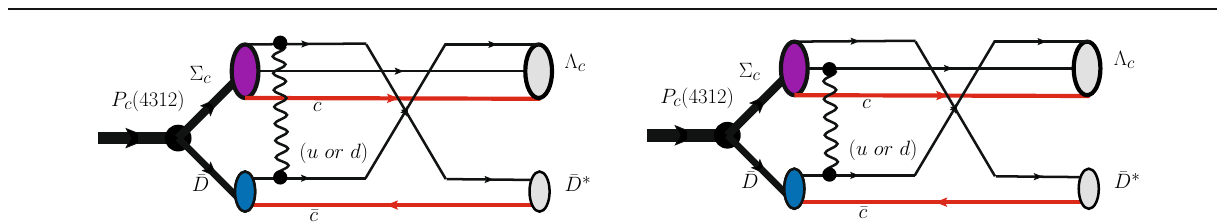
sub-diagram) belongs to a type where only one interacting quark partic- ipatesinthequarkexchangeatthesametime,whiletheotherinteracting quark does not. It should be mentioned that in this process, there also exists another possible rearrangement which occurs between 2-nd and 4-th quarks